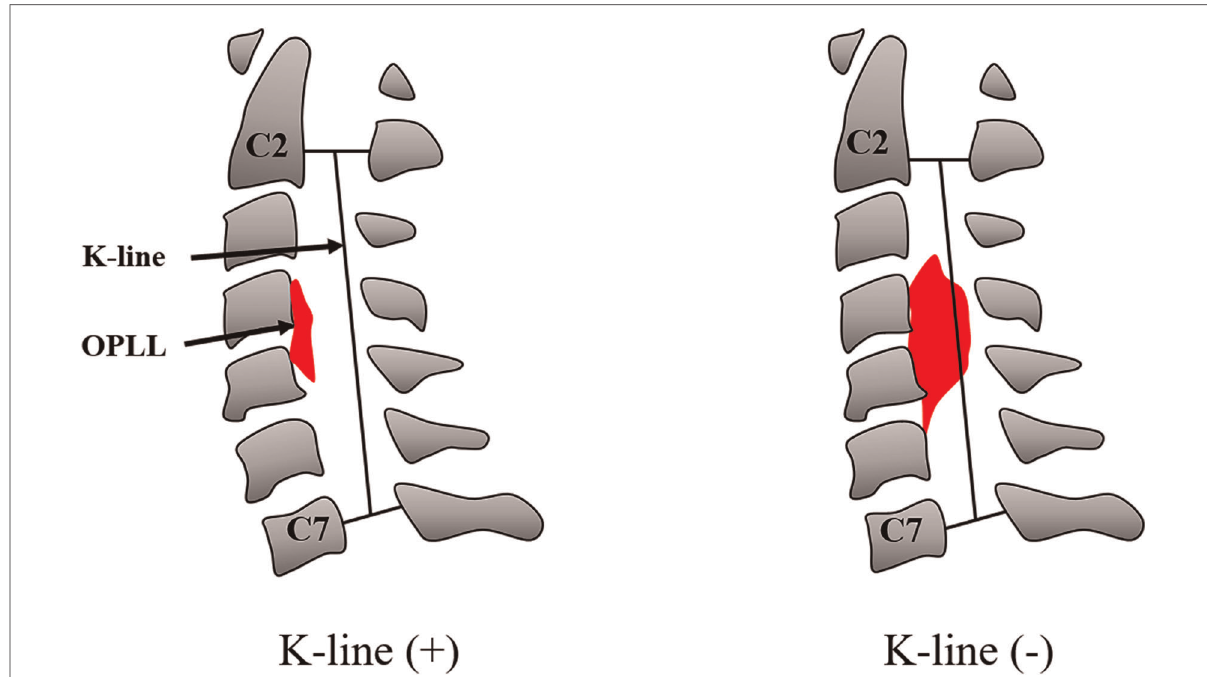
FIGURE 2 Schematic diagram of the K-line. The K-line is the line connecting the midpoints of the spinal canal at C2 and C7. The OPLL does not cross the K-line in K-line (+) group. The OPLL exceeds the K-line in the K-line ( − ) group. OPLL, ossi fi cation of the posterior longitudinal